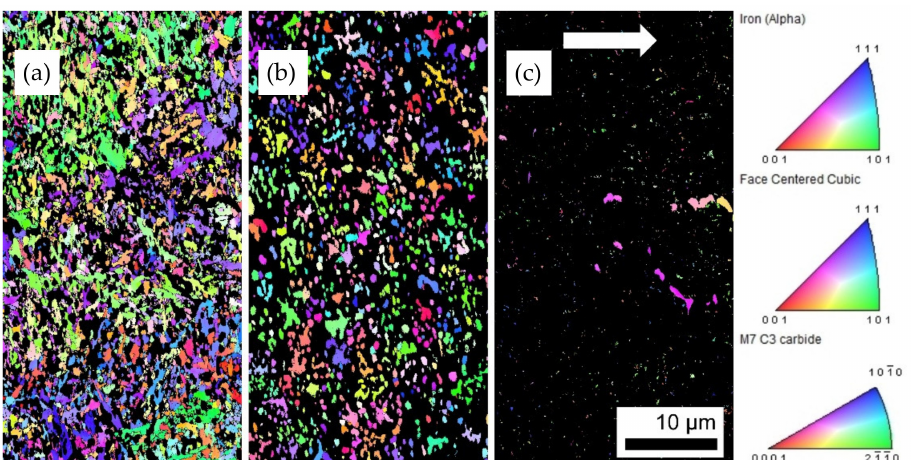
Figure 6. IPF of detected crystalline phases M7C3 ( a ); ferrite (alpha) ( b ); and fcc phase ( c ), in the as-built FeCr-10V open thin-walled cylinder. White arrow indicates the build direction.